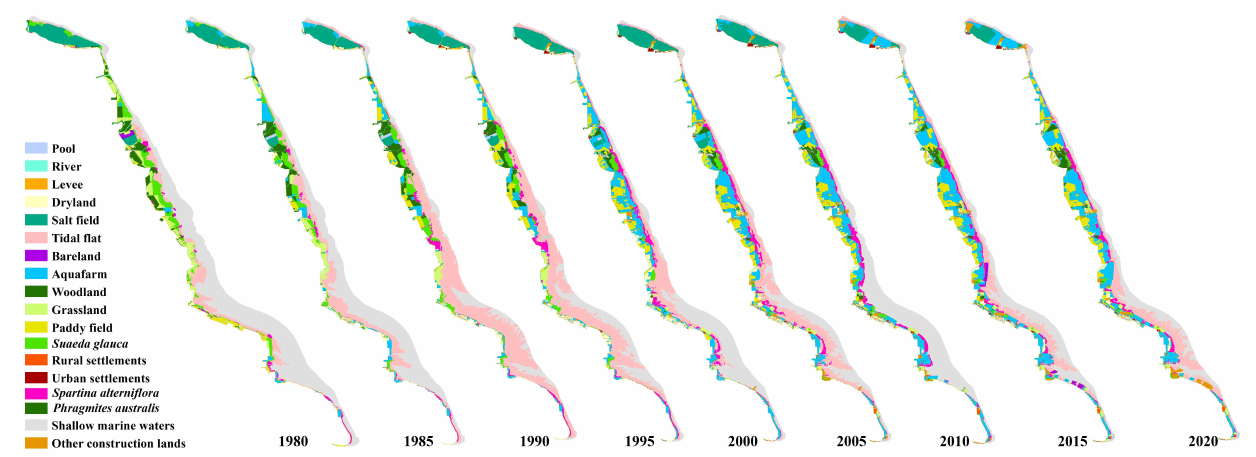
Figure 3. Time-series classification maps from 1980 to